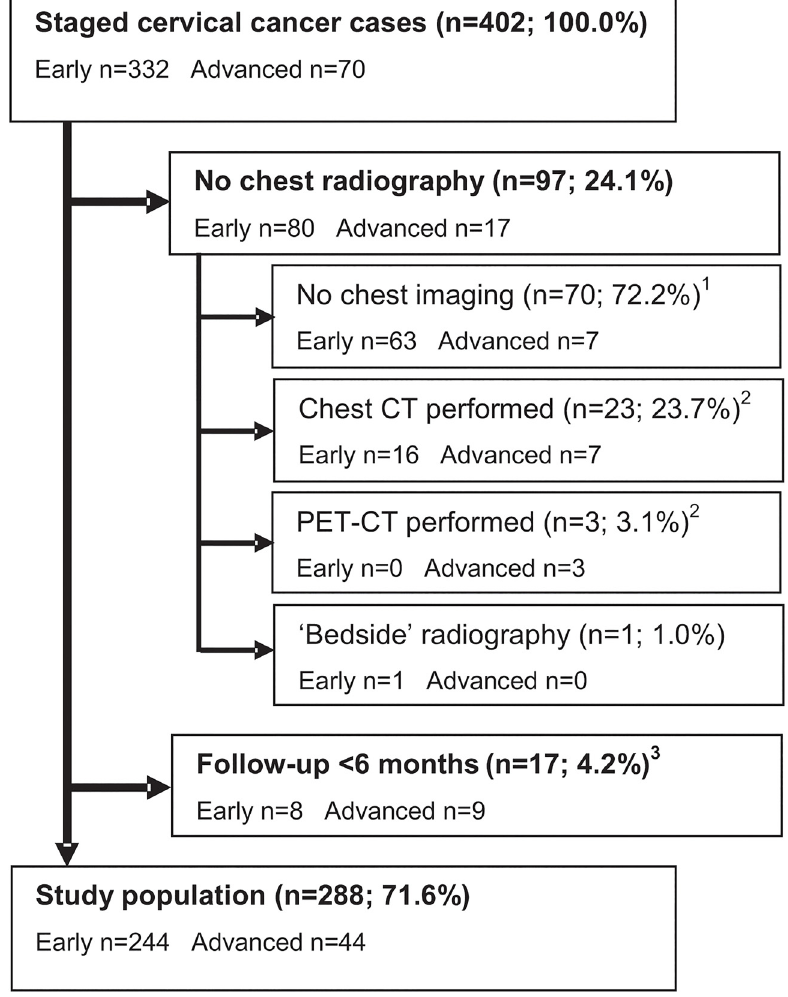
Fig 1. Flowchart displaying the formation of the study population. 1 None of these 70 cases had findings during the available follow-up period that would have induced a stage change to IVB. Follow-up of at least 6 months was available in 58/70 (82.9%) cases, including 6 of the 7 advanced cases (85.7%). 2 In 20/23 chest CT (87.0%) and all PET-CT cases, imaging was already performed by the referring center. Consequently, chest radiography was not repeated upon formal staging at our institution. In 1 subject (3.8%) pulmonary metastases were found, though in none of the in total 5 FIGO IVB cases (19.2%) upstaging was